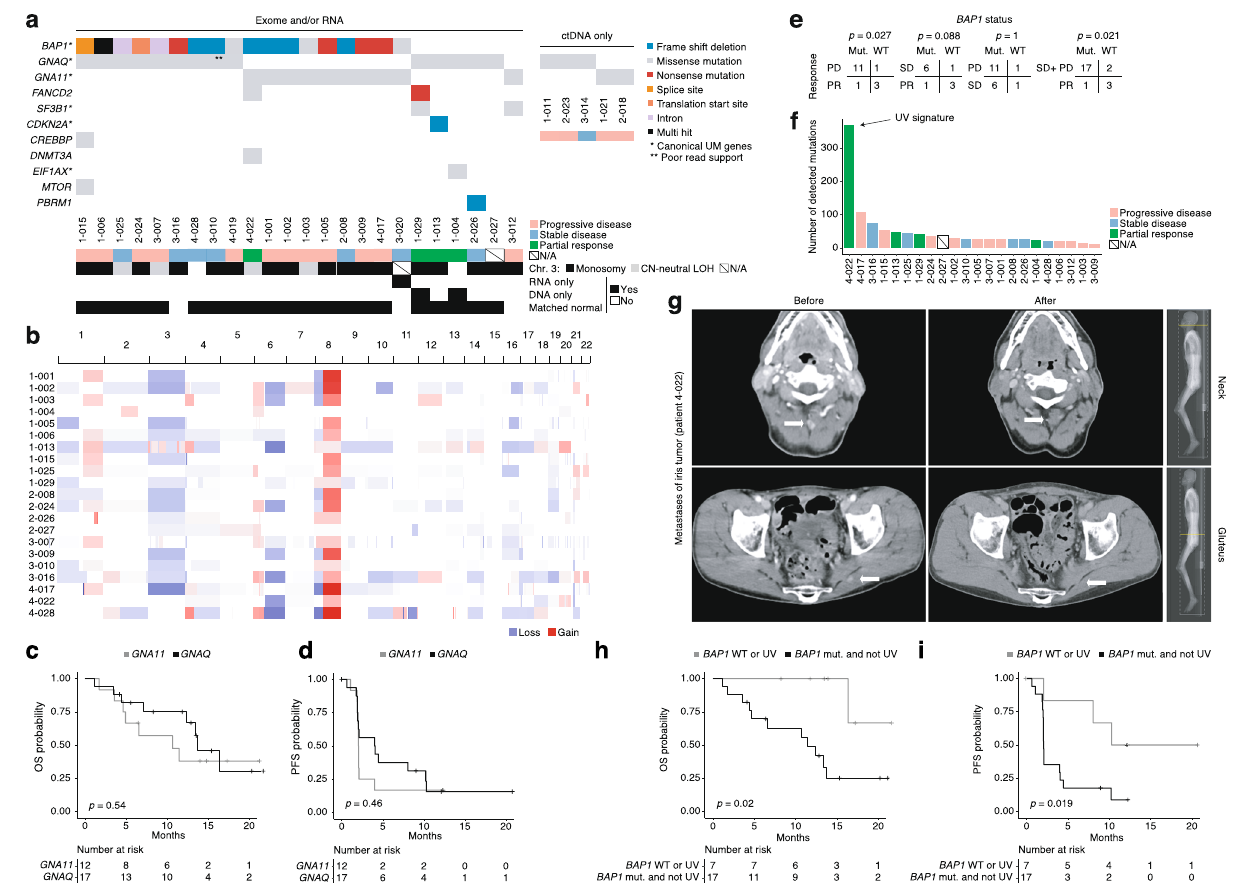
Fig. 2 Genetic analyses of pretreatment biopsies from patients recruited to the PEMDAC trial. a Mutations in genes that are either recurrently altered in UM or listed among COSMIC Cancer Gene Census driver genes. Responses in the trial are indicated. b Copy number pro fi les of each tumor inferred from exome sequencing data of tumors and matched normal tissue. Differences in color intensity depend on copy number amplitude and tumor purity. c , d OS and PFS analyses comparing patients with GNAQ - or GNA11 -mutated UM ( n = 21). e Fisher ’ s exact test of BAP1 mutational status versus responses in the PEMDAC trial. PD: progressive disease; SD: stable disease; PR: partial response. f Number of detected mutations from exome-sequencing data. g CT scans of patient 4 – 022 at baseline and at best response (22 months post therapy). Arrows show PET-positive lesions that disappeared from the dorsal neck region and left gluteus. h , i Comparison of OS and PFS to assess if UM patients with a wild-type BAP1 status or a UV-damaged genome survive longer than the other patients ( n = 24). In ( c , d ) and ( h , i ), p -values for survival associations were calculated using log-rank tests. No adjustments for multiple comparisons were made. All statistical tests were two-sided. Source data are provided as a Source Data fi